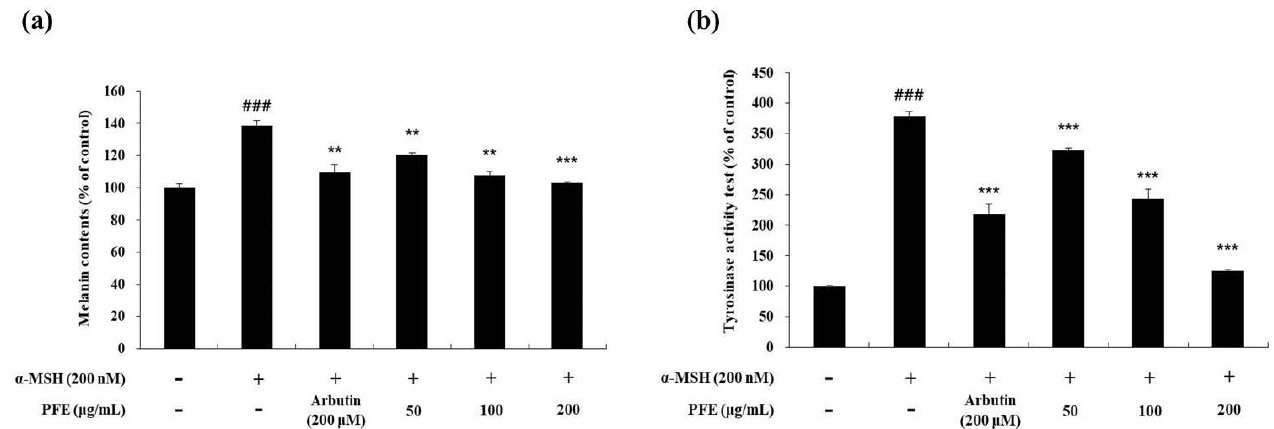
Figure 2. Variation in ( a ) melanin content and ( b ) tyrosinase activity of B16F10 cells to PFE treatment concentration. The cells, alpha-Melanocyte-stimulating hormone (α-MSH)-stimulated, were treated with the PFE and arbutin (200 μM). Results in each graph are represented as the mean ± SD of at least triplicate experiments. ### p < 0.001 vs. non-treated. ** p < 0.01, *** p < 0.001 vs. α-MSH-treated alone.